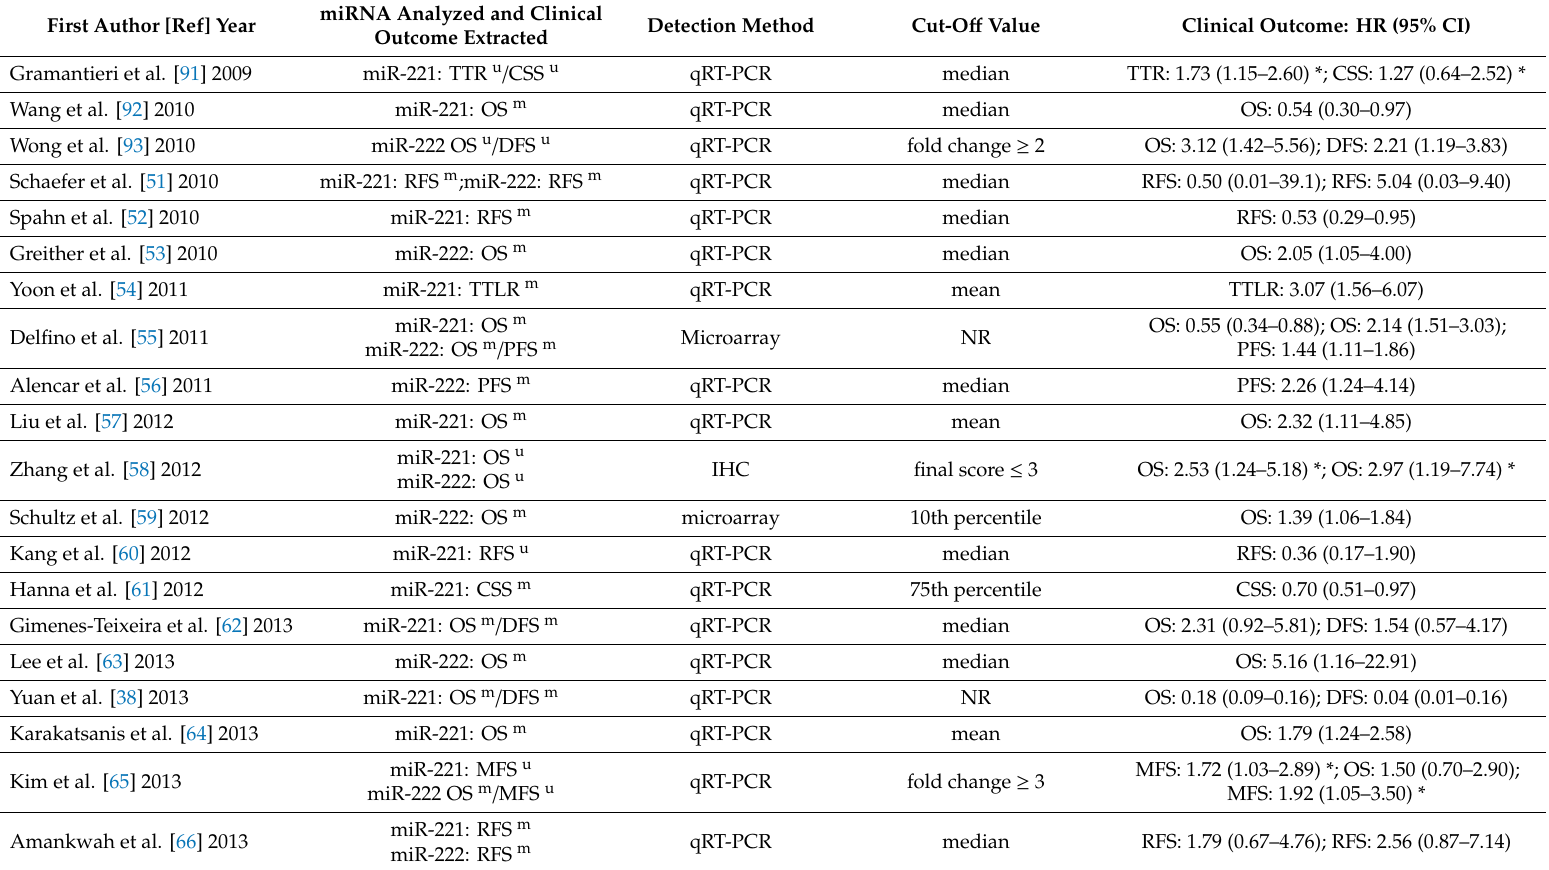
Table 2. Characteristics and prognostic information extracted from the studies included in the systematic